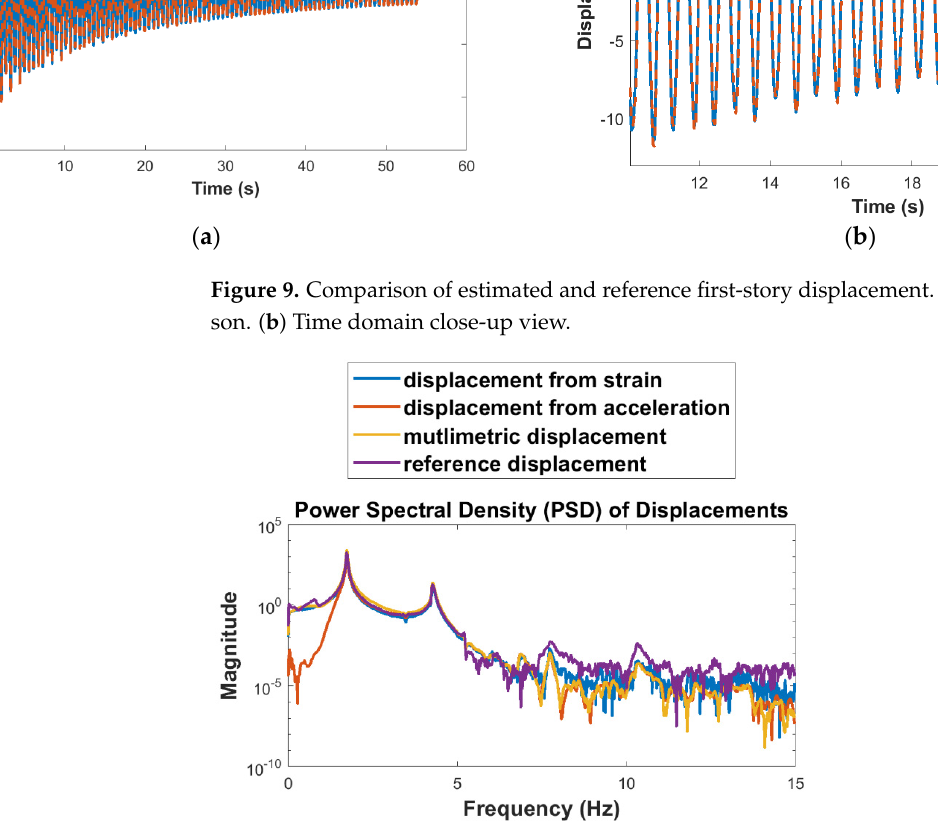
Figure 10. Comparison of estimated and reference first-story displacement in frequency domain.